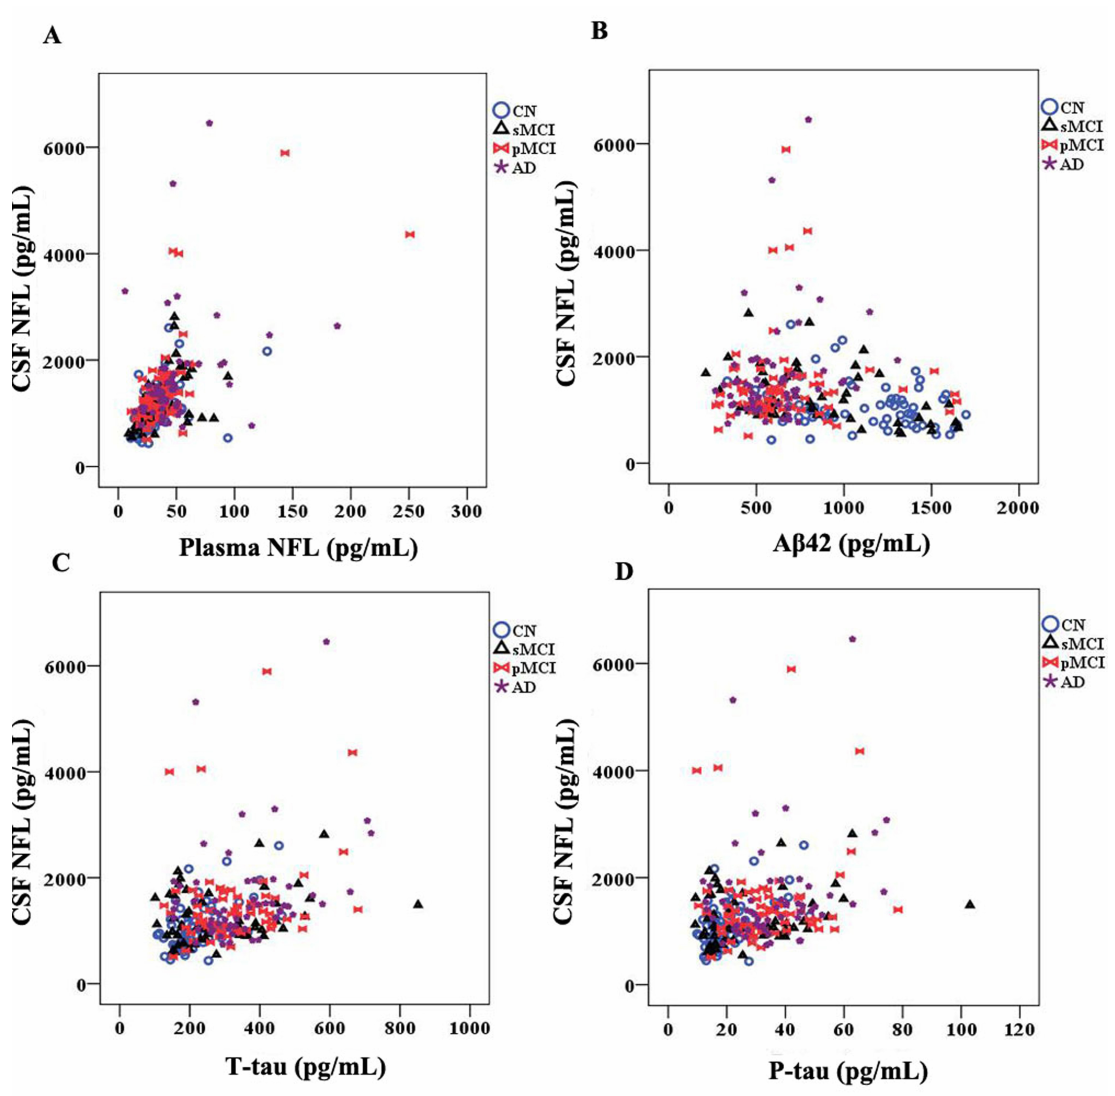
Fig.2. CSFNFLinrelationtoplasmaNFLandotherbiomarkers. Relationships between CSF NFL and plasma NFL(A) and A β 42 (B)and tau biomarkers (C and D) in different groups.